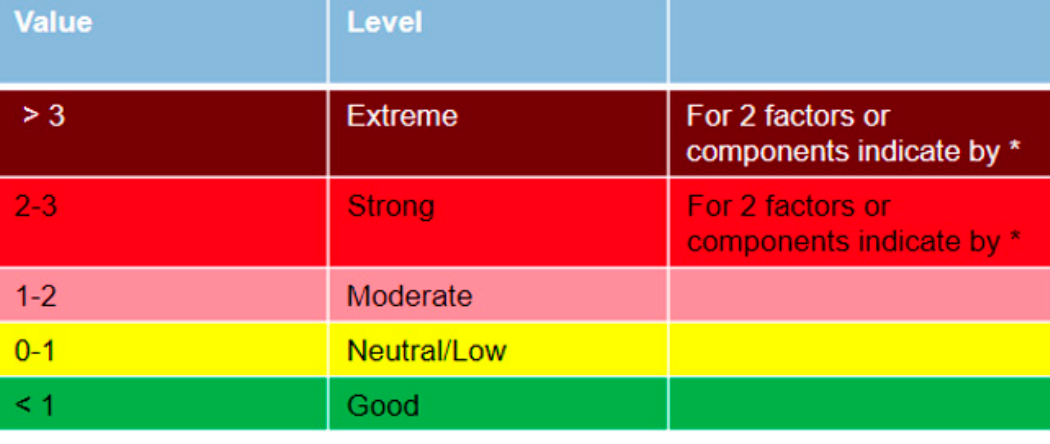
Figure 5. Classification approach.